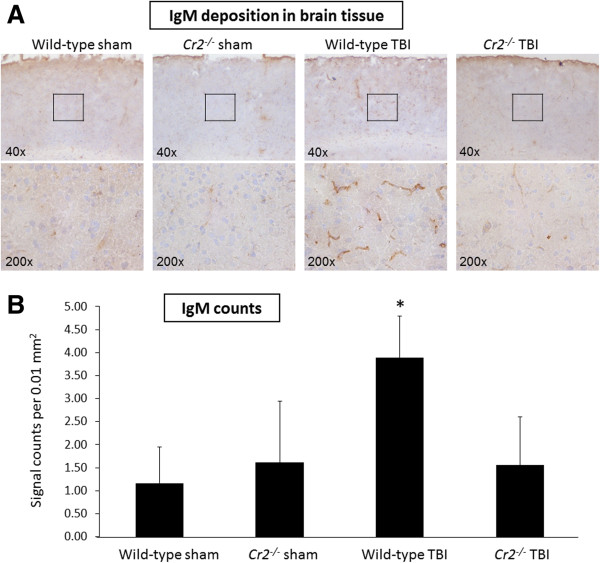
IgM deposition is attenuated in Cr2-/- mice at 24 hours after traumatic brain injury (TBI). Immunohistochemistry of coronal brain cryosections was performed using an antibody specific to the μ chain for detection of IgM. Tissue deposition of IgM was markedly increased in the injured left hemispheres of wild-type mice. In contrast, head-injured Cr2-/- mice showed low basal levels of IgM signals, to a similar extent as in sham-operated control mice (A). The inserts in the upper panel (40 ×) reflect the according selection in the corresponding higher magnification images (200 ×). For quantitative analysis, IgM signals were counted in 20 randomly selected cortical fields of 0.01 mm2 per section (B). Cell counts were performed using QCapturePro7 software (QImaging).and values are shown as mean values ± SD. *P <0.05 for wild-type TBI compared to Cr2-/- TBI and sham controls. IgM, immunoglobulin M.